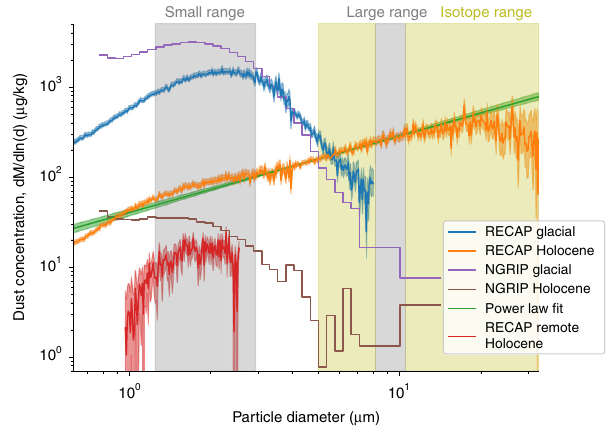
Fig. 2 Dust size distributions in RECAP and NGRIP ice cores. RECAP dust size distributions were measured by Coulter Counter. The glacial data cover the time period (12,800 – 33,900) ± 500 years b2k, while the Holocene covers selected samples from the period (356 ± 2 − 4010 ± 50) years b2k. A power law is fi tted to the Holocene data from 4 to 6 μ m and extrapolated to 0.9 μ m, with the residual Holocene dust relative to the power law fi t shown in red. It is interpreted as the size distribution of the RECAP remote Holocene dust. The coloured shadings around the curves are 1 σ errors. The grey bars show the size ranges assigned to represent small and large particles in the RECAP dust time series. The yellow area shows the